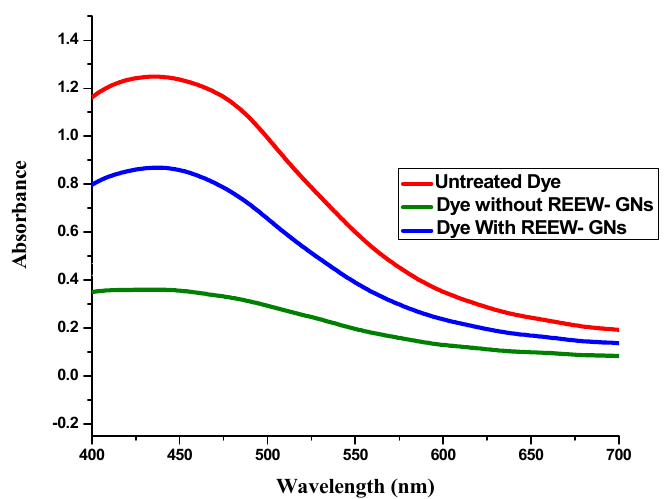
Figure 6. Absorption spectra of phenol red as target/probe molecule to study the • OH scavenging activity of REEW-GNs: the spectra of phenol red dye with and without REEW-GNs are shown for comparison.